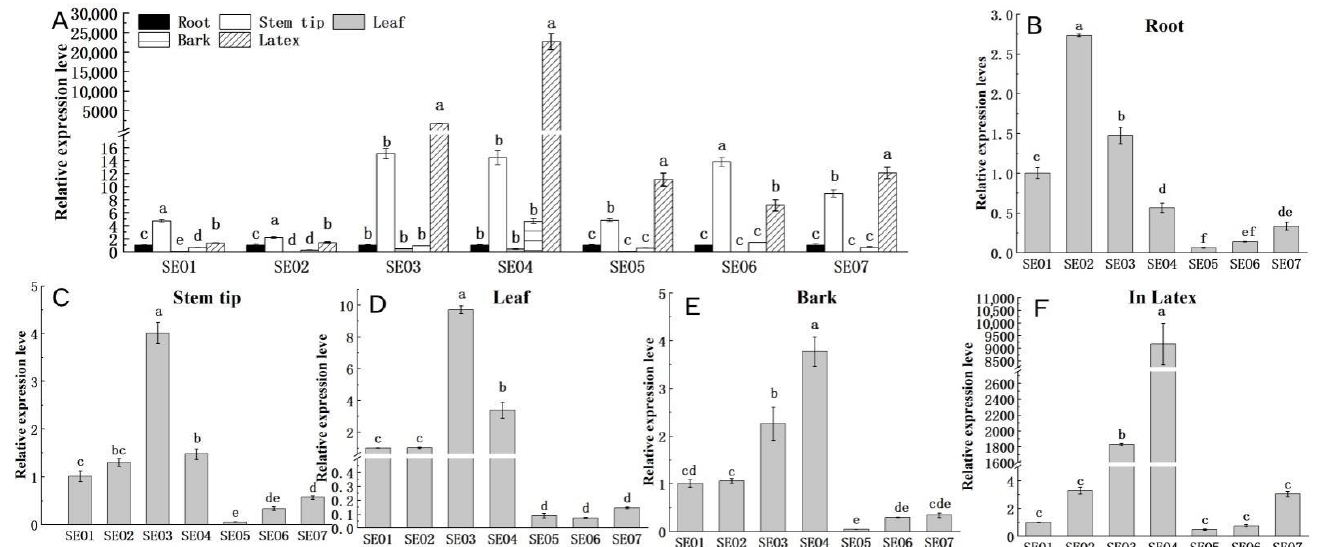
Figure 7. Relative expression of HbSEOs in different tissues and latex. ( A ) The expression of the same HbSEOs in different tissues and latex. ( B – F ) The expression of different HbSEOs in the same tissue and latex. ( A – F ) were plotted by using the same set of data, whereas different normalization criteria were utilized. In ( A ), the expression level of each gene in roots was used as a standard to normalize and compare the gene expression level among various tissues and latex, while in ( B – F ) the expression of HbSEO1 in the corresponding tissues and latex was used as a standard, to perform normalization and compare the relative expression of different genes in the same tissue or latex. The error bars denote SE from three separate replications, different small-case letters signify statistical differences between means following Duncan’s one -way ANOVA ( p < 0.05), the same applies to the following.